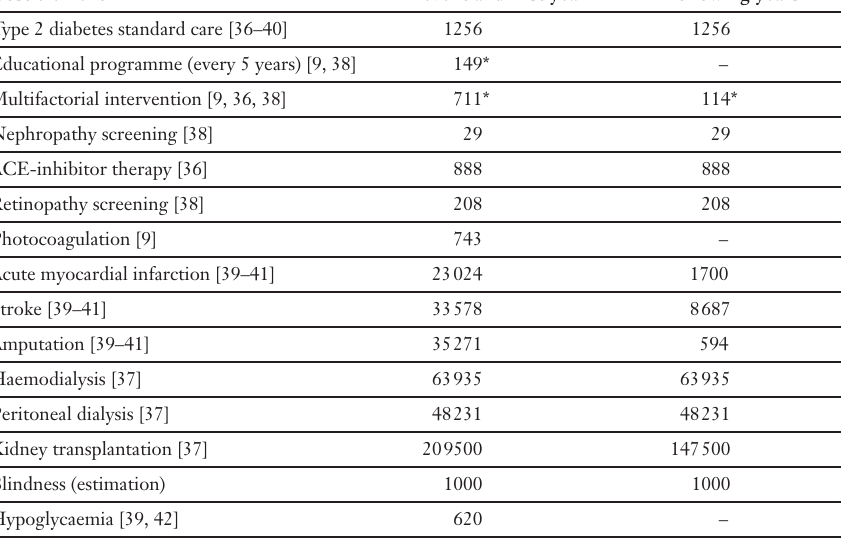
Cost data used in the model (CHF in 1996